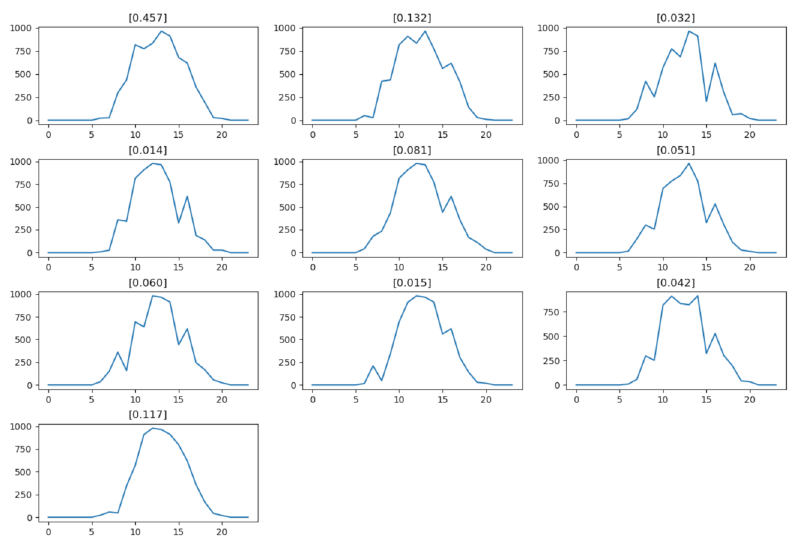
Figure 13. Ten preserved scenarios of solar irradiance for summer season with probability of occur- rence in the title.